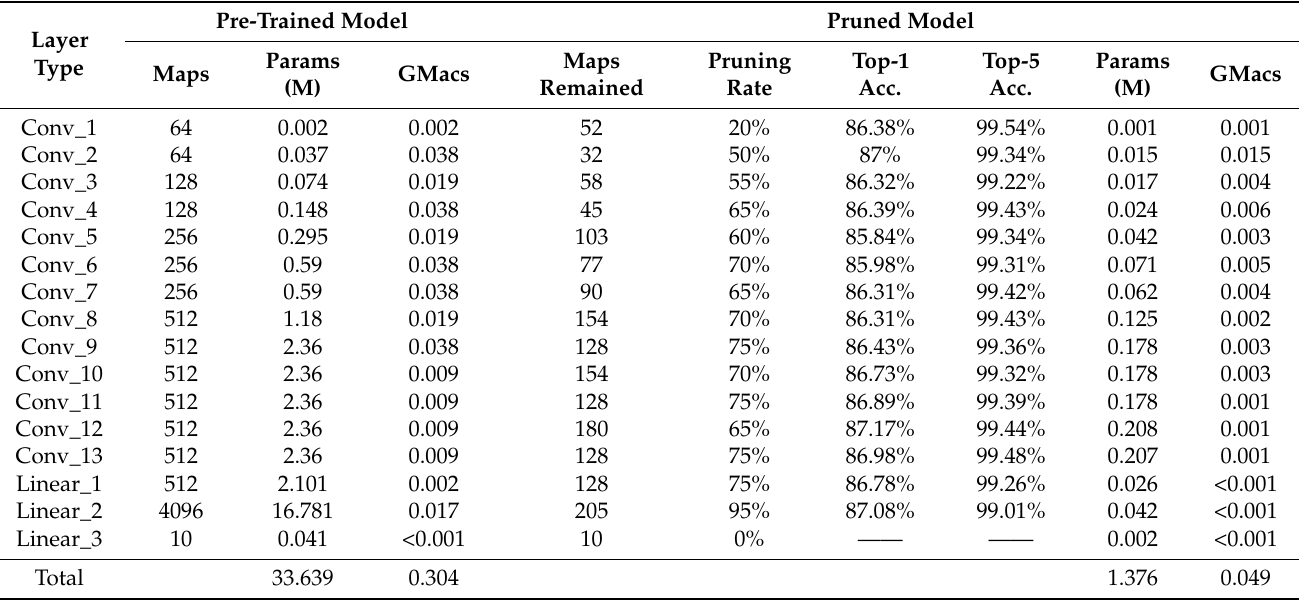
Table 3. VGG16 On CIFAR10 and the Pruned